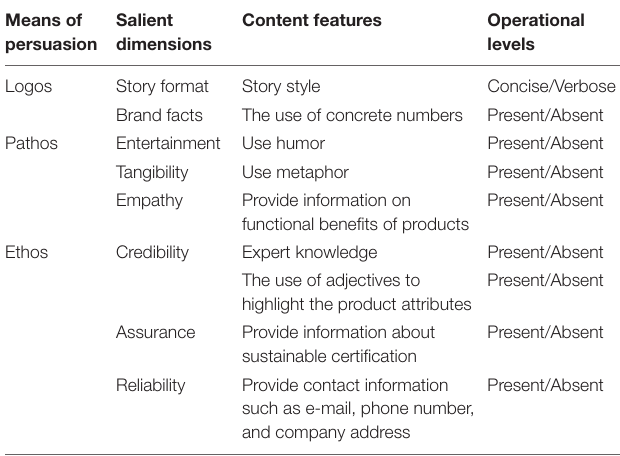
TABLE 1 | List of manipulated factors in a green brand